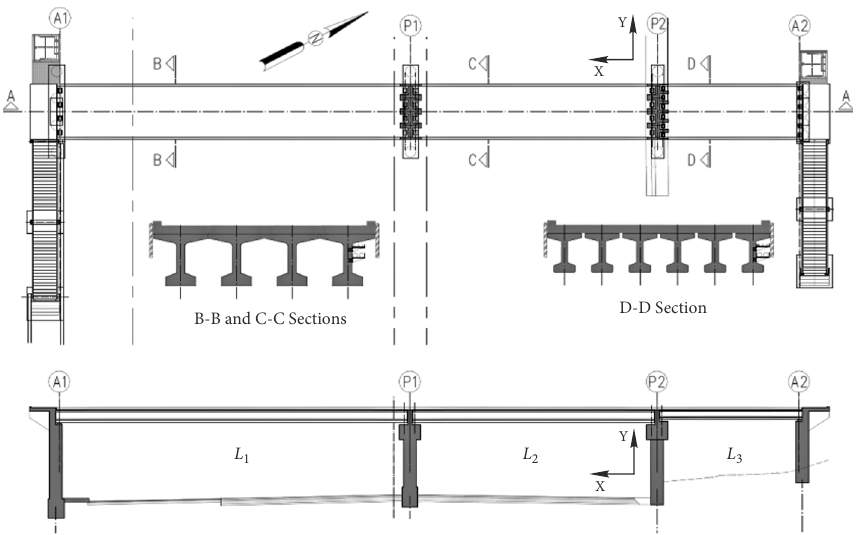
Figure 2. Structural system of the studied bridge (Oruç et al.,